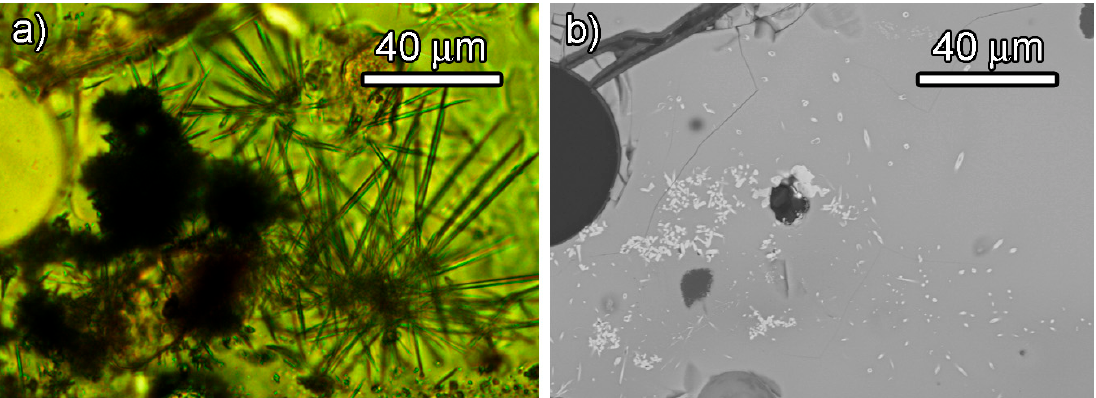
Figure 2. ( a ) A photomicrograph of the blue glaze decoration under TL: Acicular crystallites of Pb–Ca arsenates are visible in the thin section. ( b ) A back scattering mode (BSE) image of the same area as Figure 2a: On the polished surface, the acicular crystallites appear as rounded/tabular crystals; some hexagonal sections could be seen with higher magnification.